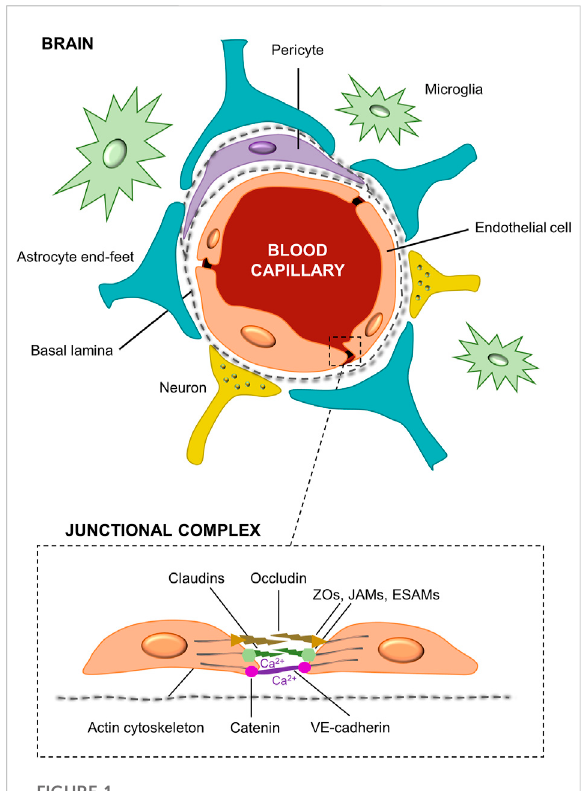
FIGURE 1 Structural diagram of the blood-brain barrier and its cellular